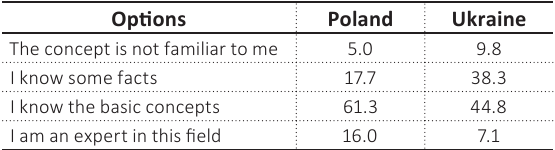
Table 4. Respondents’ answers to the question: How well do you know the concept of social responsibility?